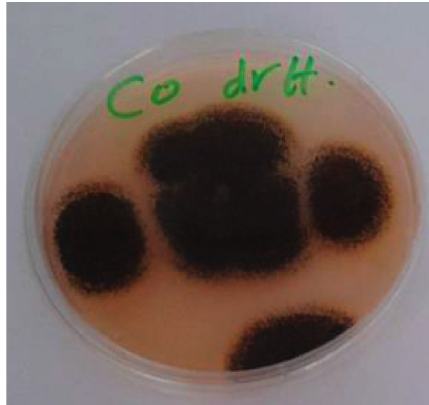
Figure 12: Inhibition zones of cobalt complex against Aspergillus